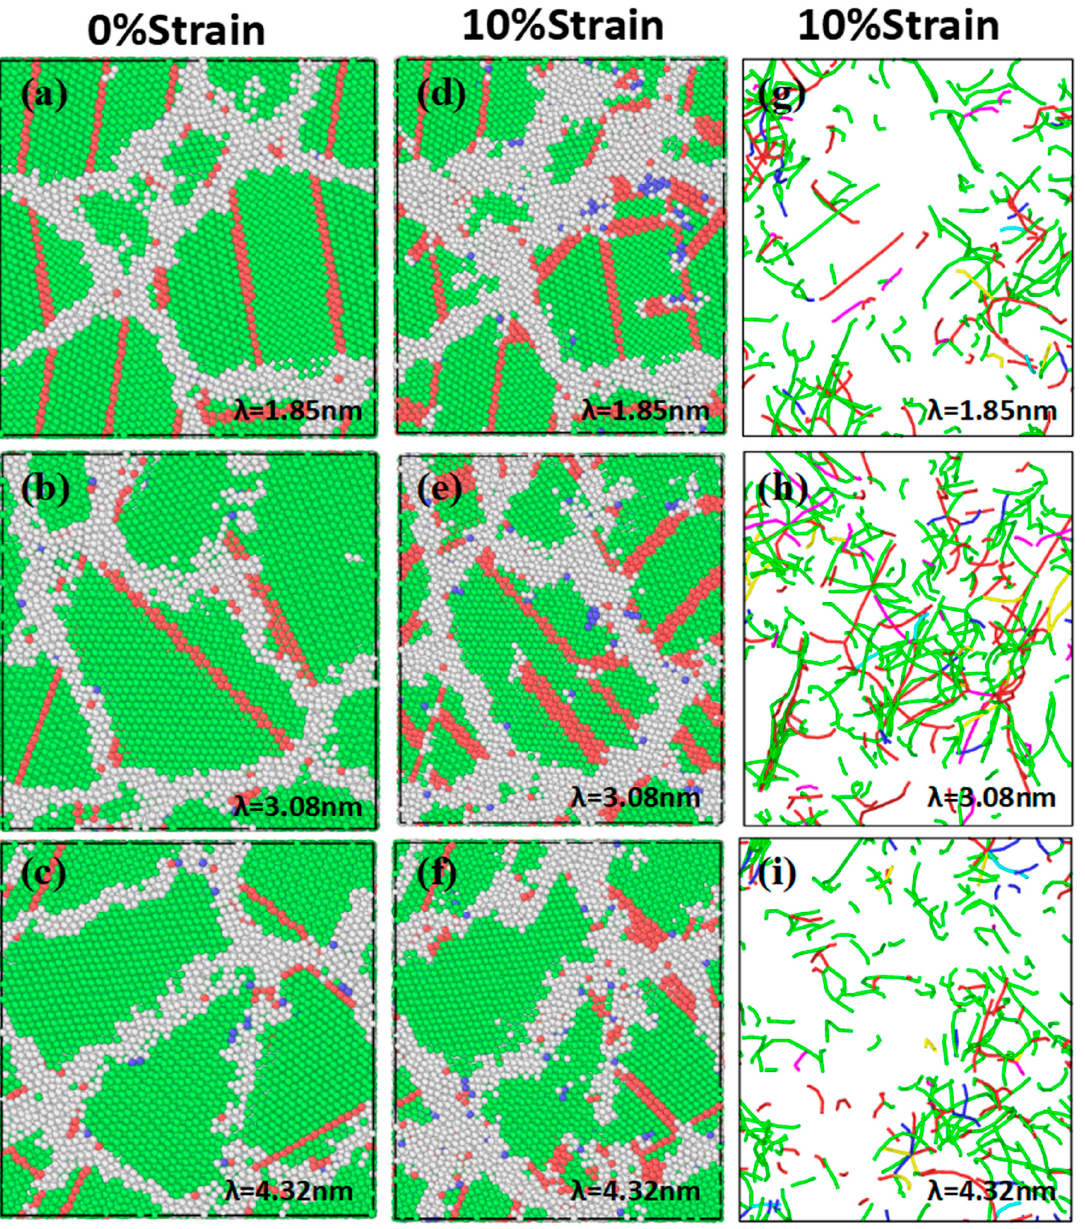
Figure 11. Initial structures at 300 K with TB spacing of ( a ) 1.85 nm, ( b ) 3.08 nm, and ( c ) 4.32 nm, structure of the samples at the strain of 10% with TB spacing of ( d ) 1.85 nm, ( e ) 3.08 nm, and ( f ) 4.32 nm, and dislocations of the samples at the strain of 10% with TB spacing of ( g ) 1.85 nm, ( h ) 3.08 nm, and ( i ) 4.32 nm.